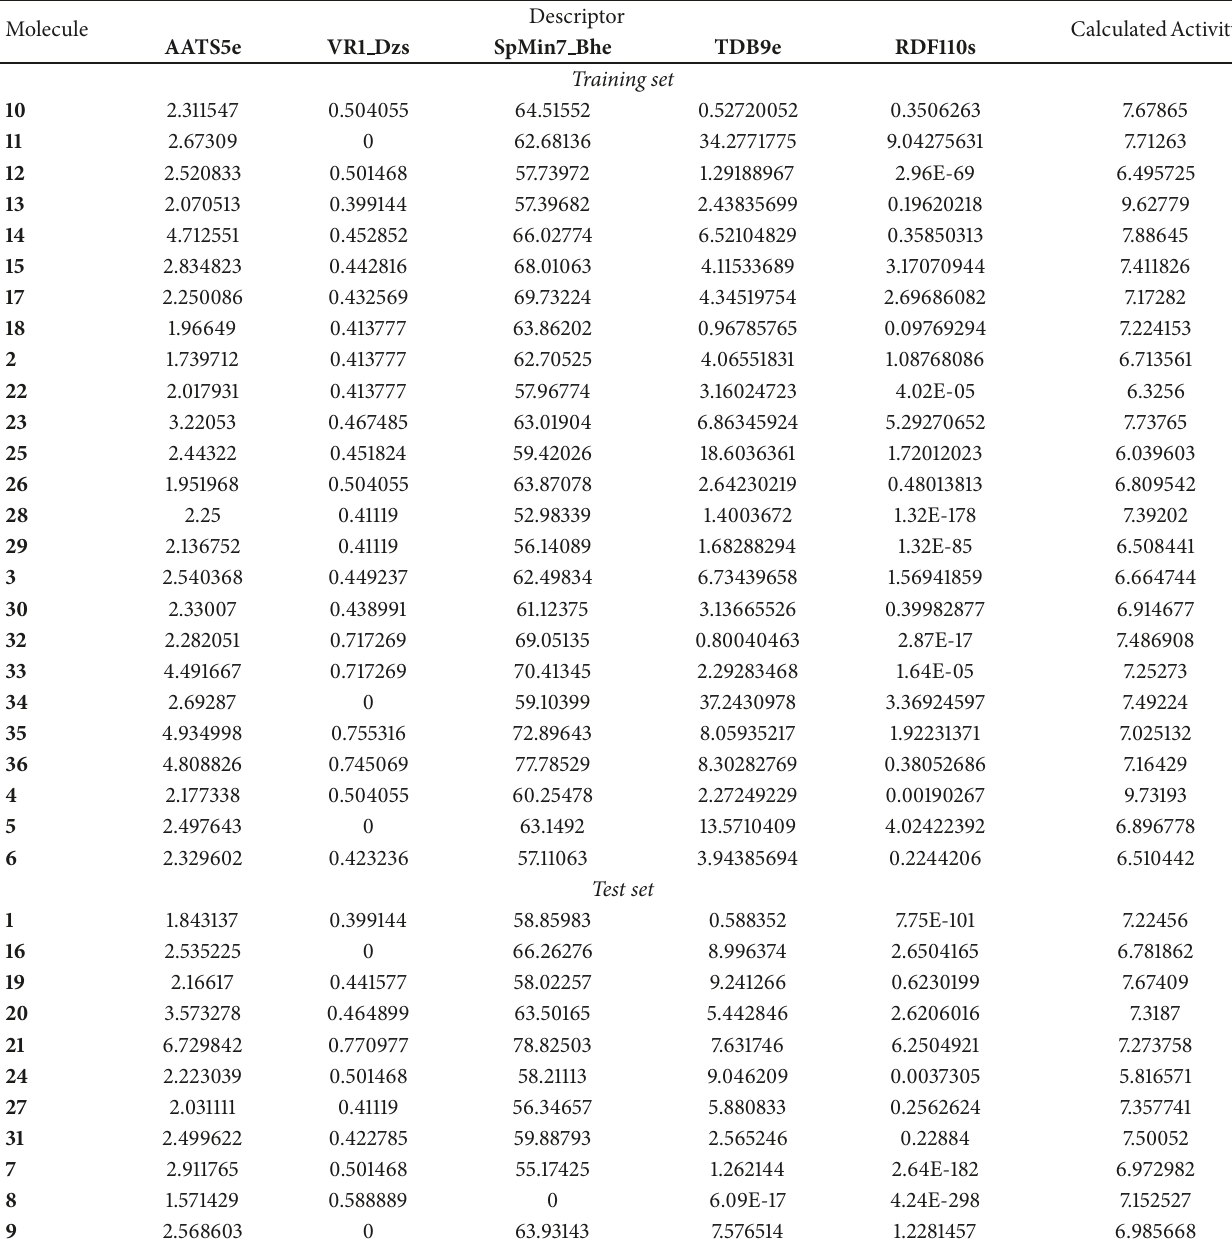
Table 2: Calculated descriptors for training set in generating model 1.